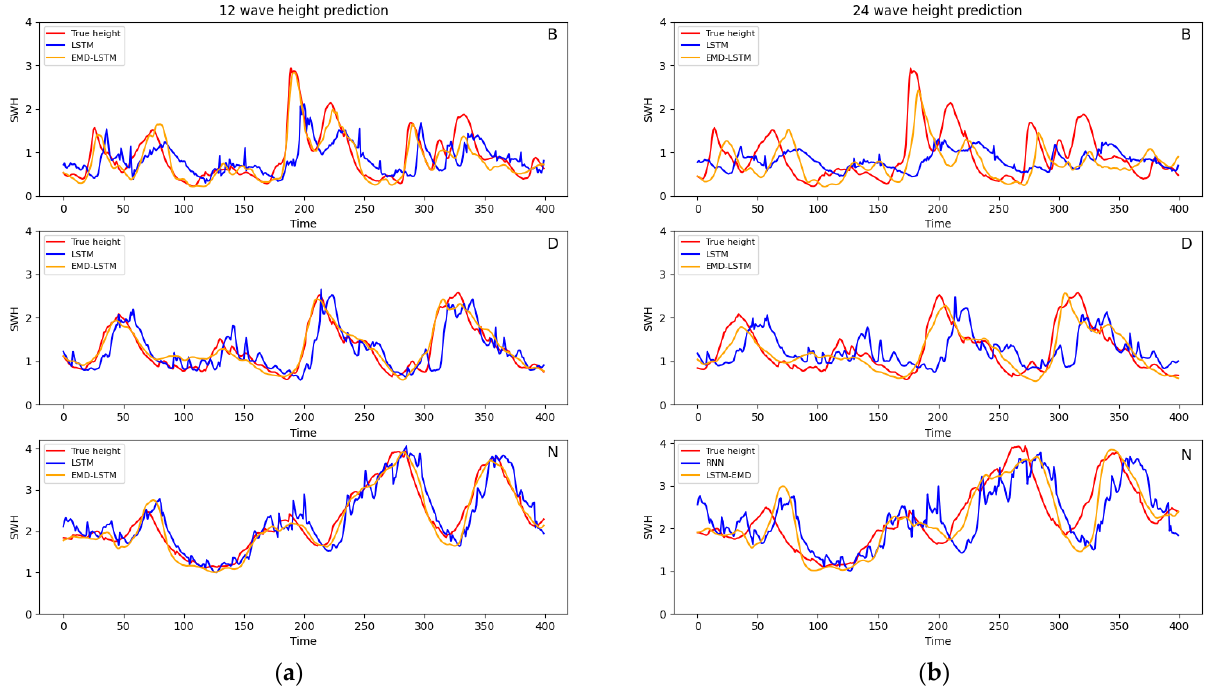
Figure 13. Twelve-hour and 24 h correction results. The abscissa represents time, the ordinate represents significant wave height, the red line represents the true significant wave height, the blue line represents the predicted value of LSTM, and the yellow line represents the predicted value of EMD-LSTM. ( a ) represents the 12 h forecast for different locations; ( b ) represents the 24 h forecast for different locations.